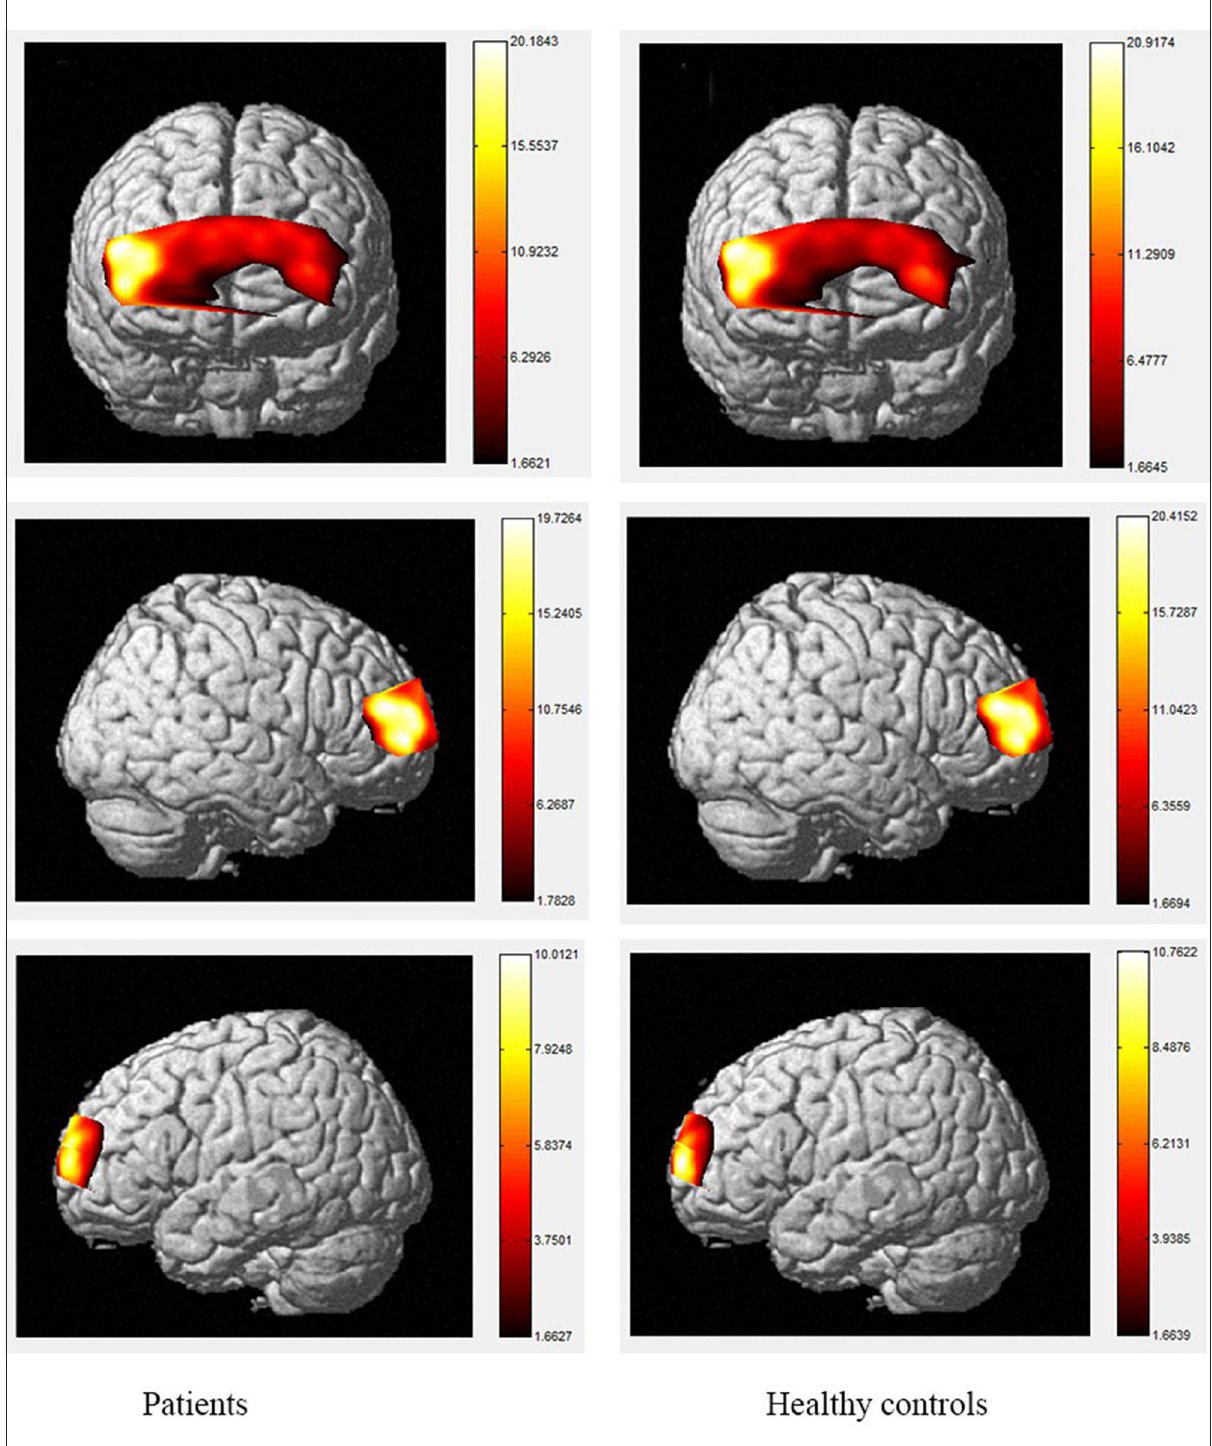
FIGURE4 The activation of brain areas during 1-back tasks between patients and healthy controls. The color bars in right sides mean the activated strength of brain